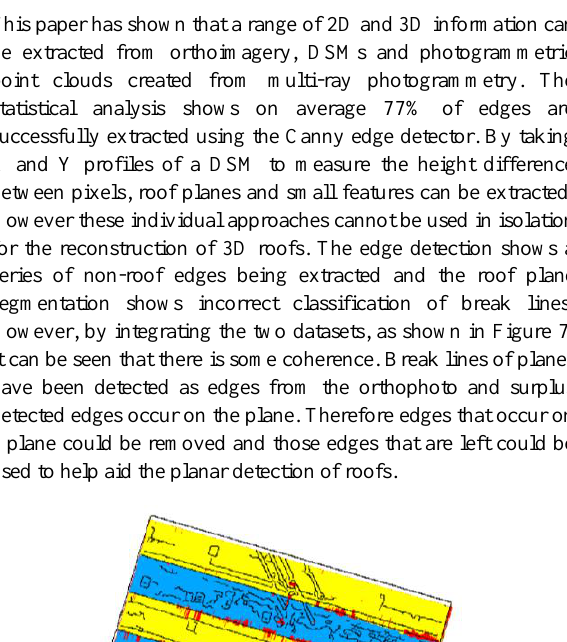
Figure 6. Buildings with neighbouring trees showing areas above the threshold (red) and below the threshold (grey) 6.